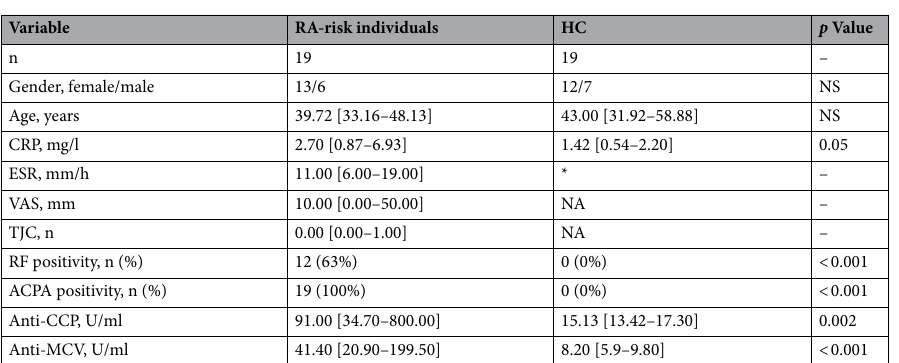
Table 1. Clinical characteristics of ACPA-positive individuals with arthralgia at risk of RA and healthy controls (Phase I). Abbreviations: ACPA, anti-citrullinated protein antibodies (positive for at least one of